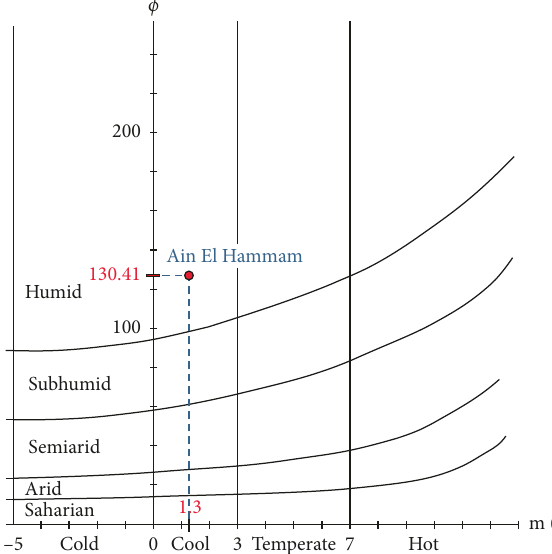
Figure 3: Emberger’s climagram of the study area (A.E.H.).